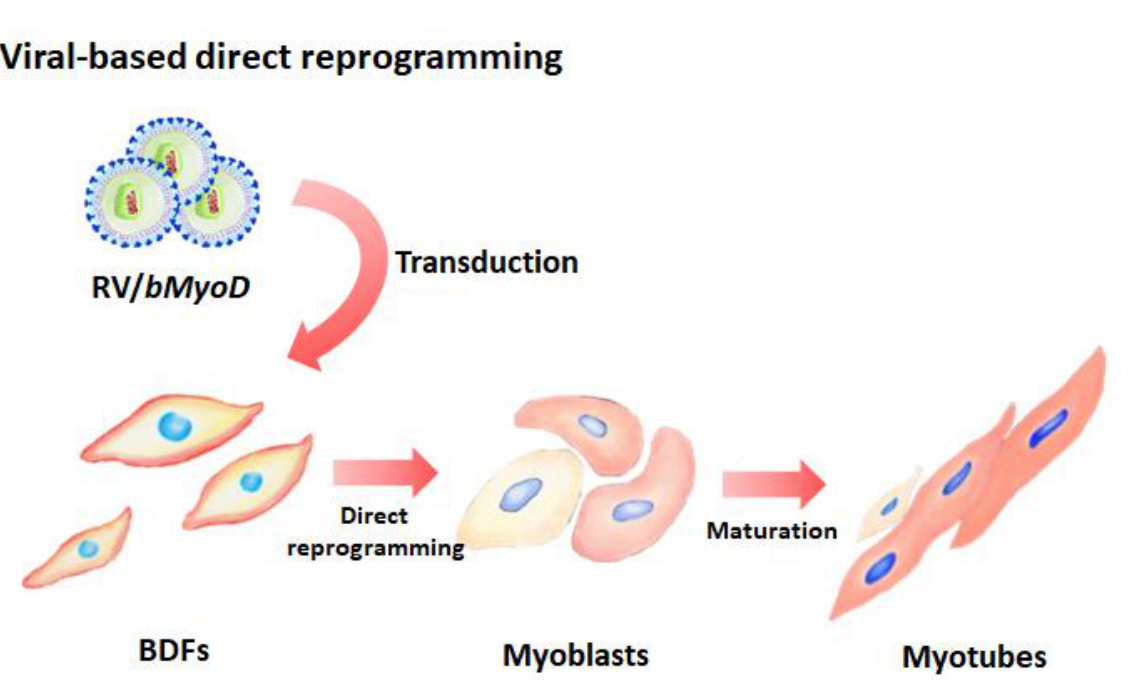
Figure 6. Schematic illustration of direct reprogramming of BDFs into myoblasts or myotubes using viral-based bMyoD delivery. ( A ) Inefficient method using protein-based approach and ( B ) efficient method using viral-based approach.